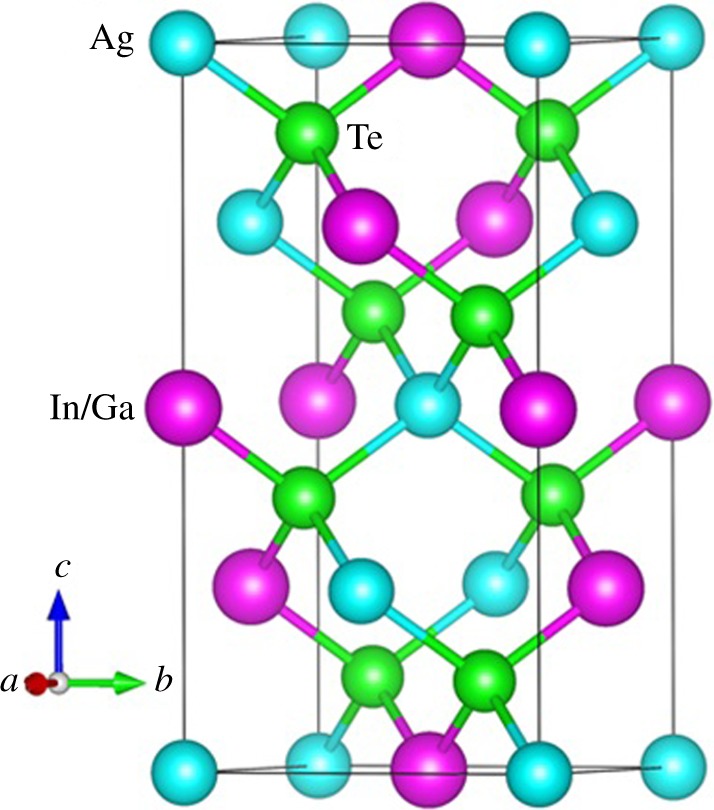
Crystal structure of AgX(In,Ga)Te2.